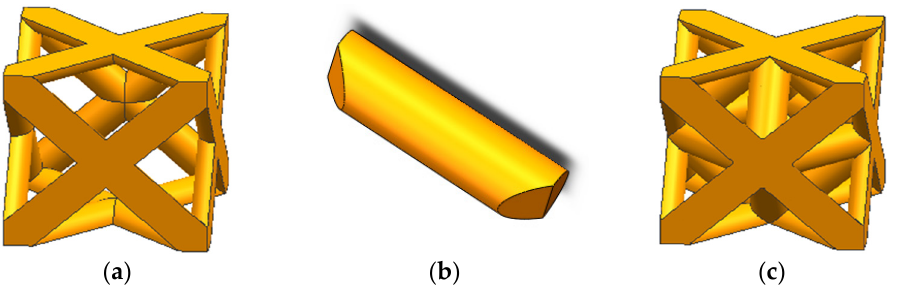
Figure 2. Structural model of the basic unit of the porous structure: ( a ) External frame; ( b ) internal struct; ( c ) Porous structure.